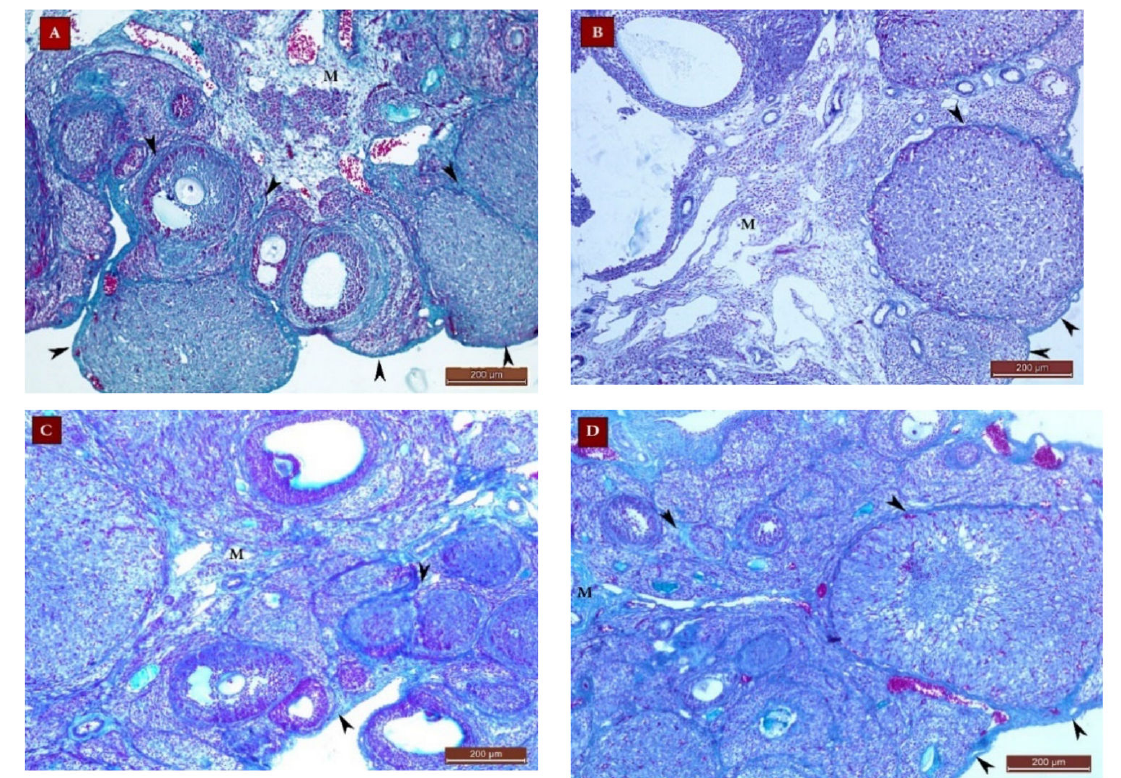
Figure 8. Masson’s trichrome stain × 100 photomicrographs of ovaries from all study groups. ( A ) Ovarian section from the control (G I) group showing normal collagen (green color) distribution in the tunica albuginea and in the cortex between and surrounding the growing follicles (arrow heads) and in the medulla (M). ( B ) Section from the POI (G II) group showing a decrease in the collagen content at the ovarian surface and in the cortex and M. Sections from the diosmin 50 (G III) group ( C ) and diosmin 100 (G IV) group ( D ) showing restoration of the collagen content at the ovarian surface and in the cortex and medulla.